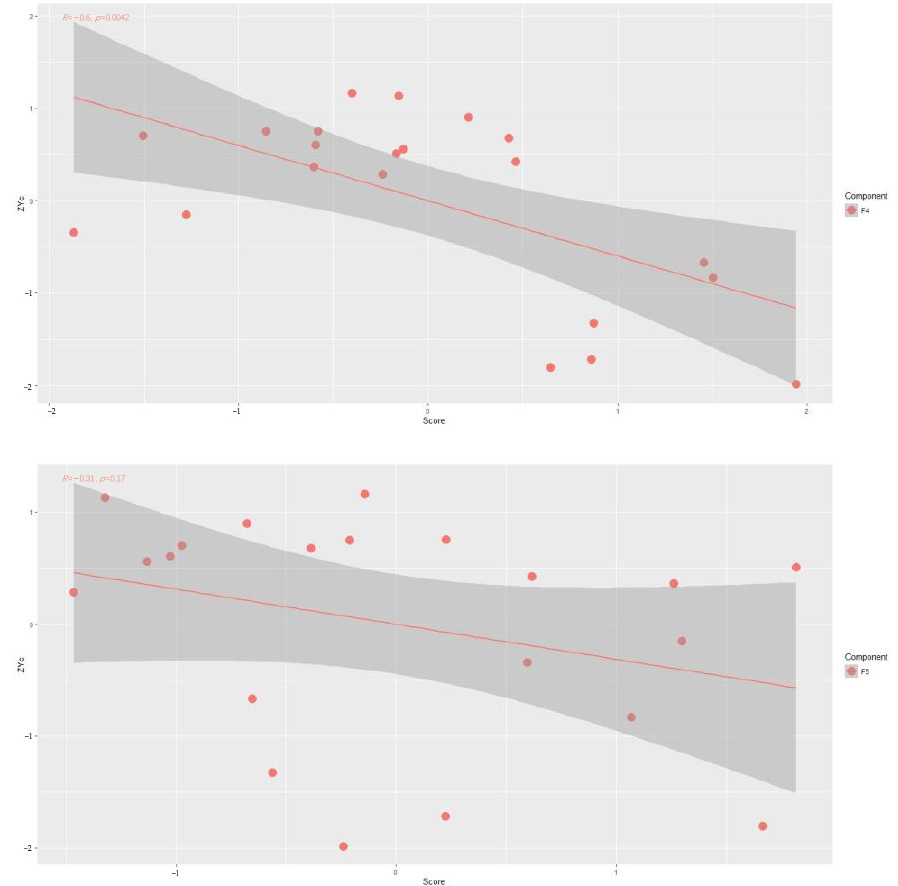
Figure 5. Relationships between normalized meteorological yield and principal components 𝐹 1 − 𝐹 5 .